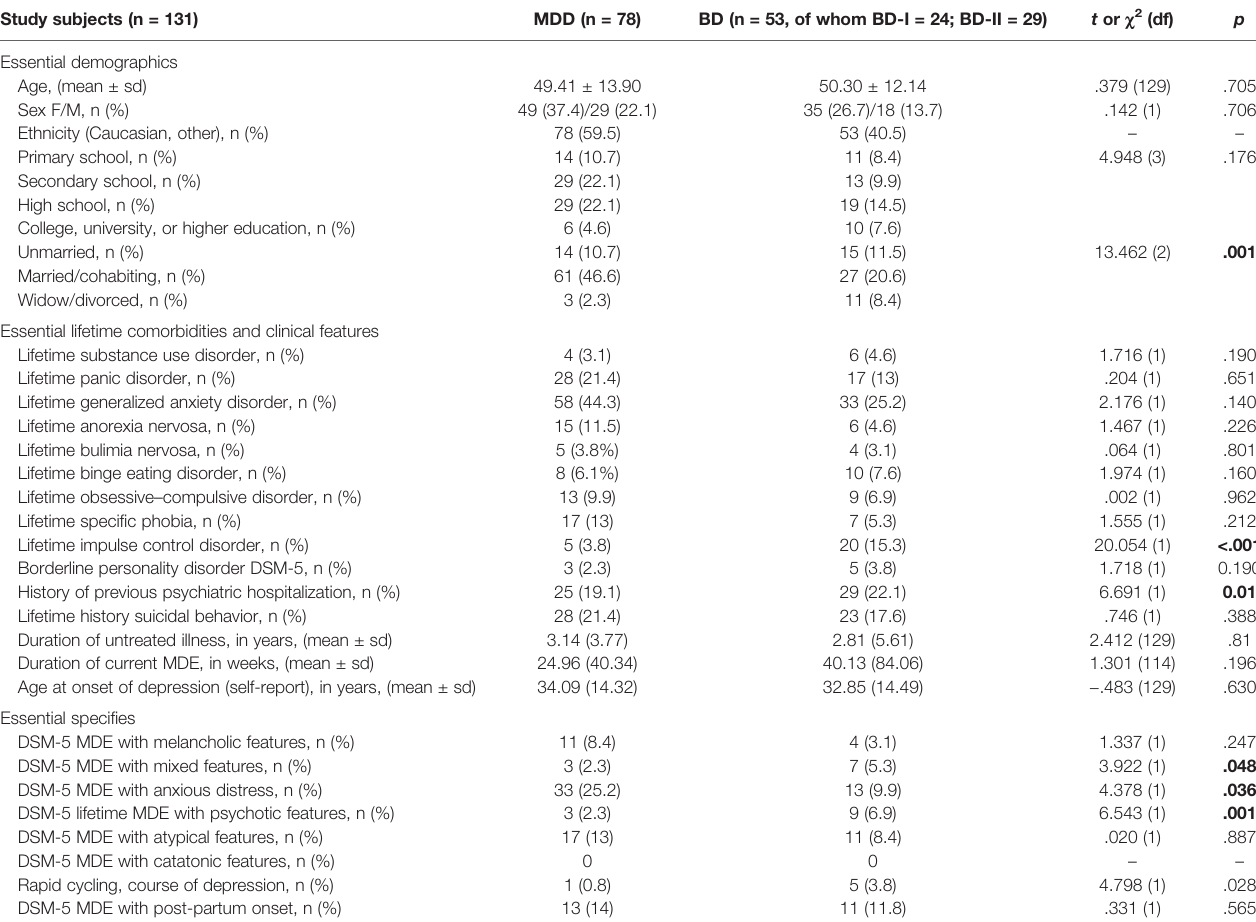
TABLE 1 | Essential clinical and demographics across unipolar and bipolar cases. Study subjects (n =